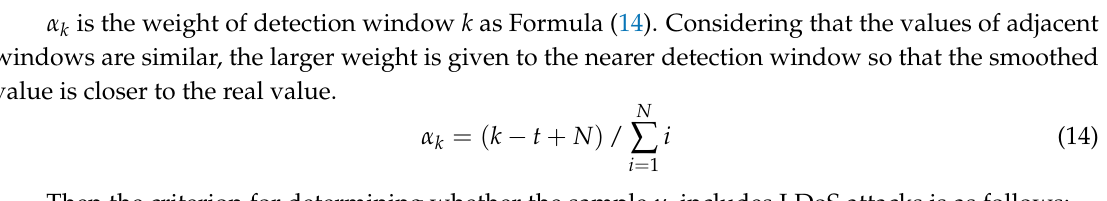
Figure 9. Smoothed anomaly score compared to the original